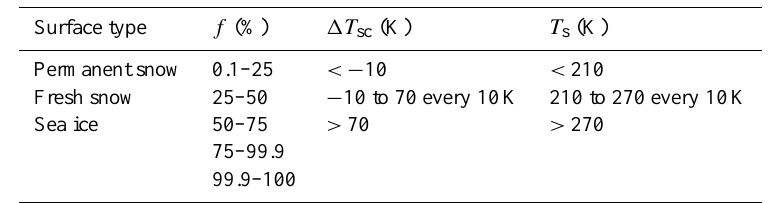
Table 6. Surface type, cloud fraction ( f ), surface–cloud temperature difference ( (cid:49)T sc ), and surface skin temperature ( T s ) intervals used to determine LW and WN ADMs over cloudy permanent snow, sea ice, and fresh-snow surfaces. There are 5 f bins, 10 (cid:49)T sc bins, and 8 T s bins.